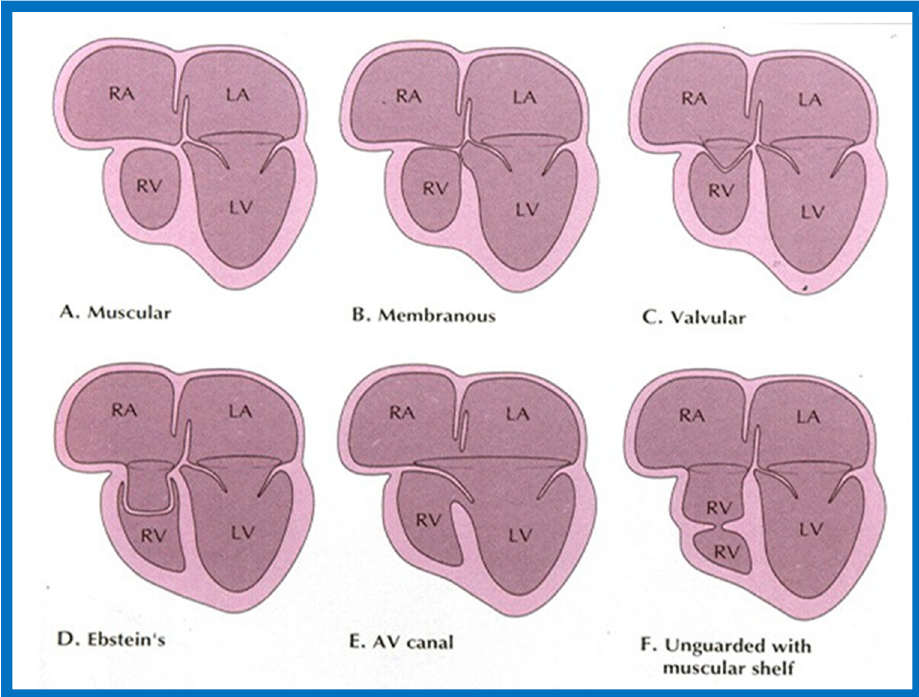
Figure 18. Classification based on morphology of the tricuspid valve is shown diagrammatically. ( A ) classic muscular type is shown with a thick band of tissue at the location where the tricuspid valve should be. ( B ) Membranous type, ( C ) Valvular type with fused valve leaflets, ( D ) Ebstein’s type with fused valve cusps along with Ebstein type of downward displacement of the tricuspid valve, ( E ) Atrioventricular (AV) canal (septal defect) type with common AV leaflet sealing off the right ventricle (RV) from the right atrium (RA), and ( F ) Unguarded muscular shelf type where the RV is divided into inlet and outlet portions by a muscular shelf. LA, left atrium; LV, left ventricle. Reproduced from Rao P.S. [40].